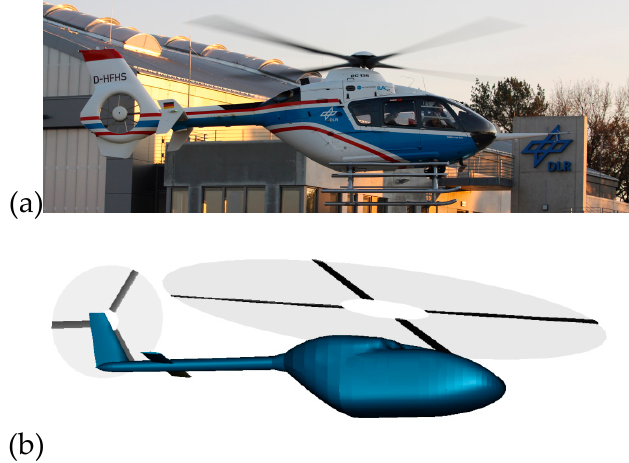
Figure 13. Visual comparison: ( a ) Photograph of the reference configuration ACT/FHS and ( b ) 3D model of the virtual configuration from IRIS.